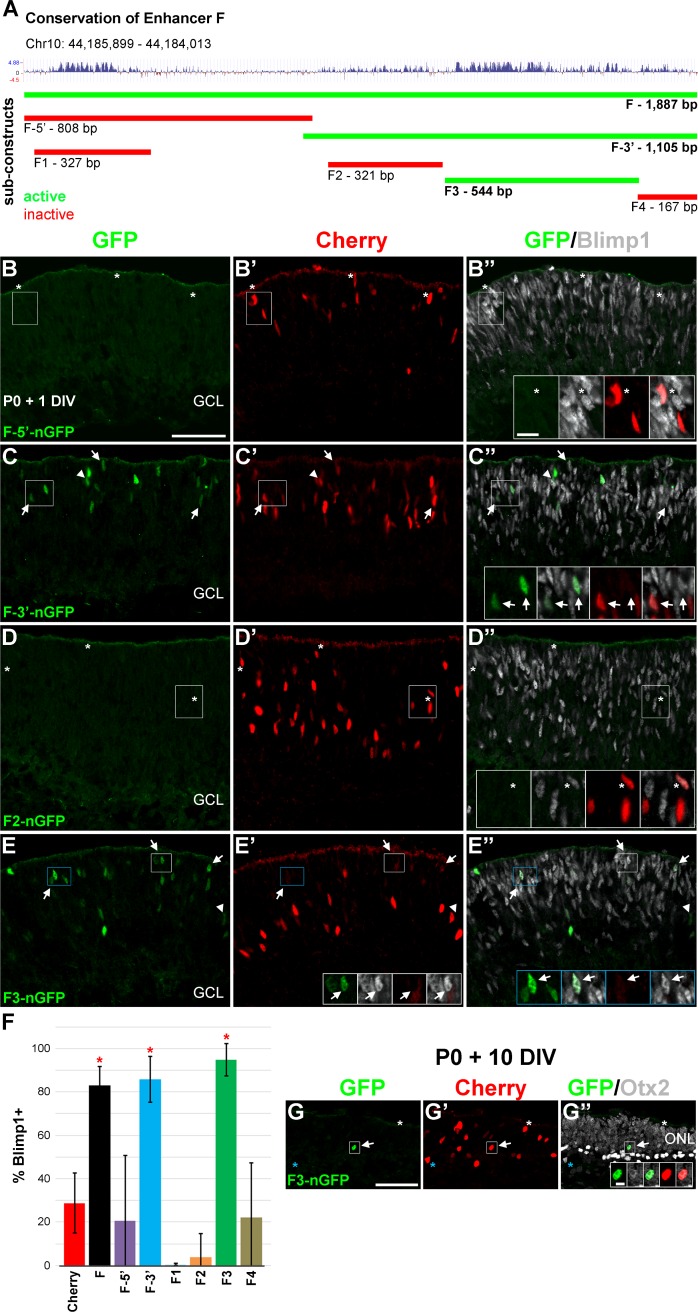
A portion of the F sequence is sufficient to drive expression in Blimp1+ cells.(A) Schematic of the 1,887bp F element showing vertebrate conservation. Upward peaks indicate higher conservation. Genomic coordinates are from the mouse mm9 assembly. Six sub-elements are shown to scale and color-coded based on their activity (green, active) (red, inactive) in explant assays. (B-B”) Explants co-electroporated with F-5’-nGFP and Cherry. GFP+ cells (green) are rare, but about a quarter of the Cherry+ cells (red) co-express Blimp1 (grey, asterisks, insets). (C-C”) The F-3’-nGFP construct is active and most of the GFP+ cells co-express Blimp1 (arrows, insets). Arrowheads mark GFP+ cells that do not co-express Blimp1. (D-D”) The F2 element has no activity. Asterisks (insets) show Cherry electroporated cells that co-express Blimp1. (E-E”) The F3 construct is highly active and about 90% of GFP+ cells co-express Blimp1 (arrows, insets). Arrowheads mark the few GFP+/Blimp1 negative cells. Scale bars are 50 μm for panels and 10 μm for insets. (F) Plot of the average percentage of Cherry+ or GFP+ cells that co-express Blimp1. Error bars represent the S.D. The F-3’ and F3 constructs show significantly more Blimp1 co-expression compared to cherry controls (*, unpaired t-test, P < 0.001). The F3 element also shows modestly, but significantly more Blimp1 overlap than the F parent element (unpaired t-test, P < 0.03). (G-G”) The F3 construct examined after 10 DIV, corresponding to when Blimp1 is no longer expressed in the retina. GFP+ cells (arrows, insets) are rarely seen, but are located in the outer nuclear layer (ONL) where Otx2+ (light grey) photoreceptors reside. The white asterisks mark a Cherry+/Otx2+ photoreceptor and the blue asterisks mark a Cherry+/Otx2+ bipolar cell (intense grey). Scale bars are 50 μm for panels and 5 μm for insets.